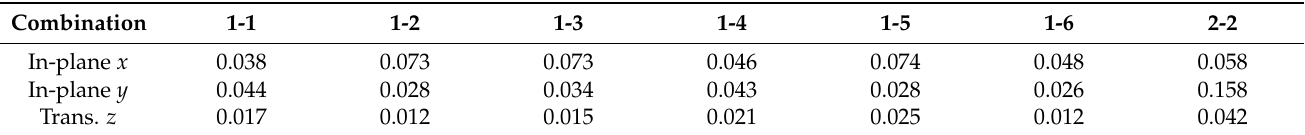
Table 3. Maximum transverse and in-plane representation error (in %) of the dual data. Freely expanding plate, 6L7D ROM.